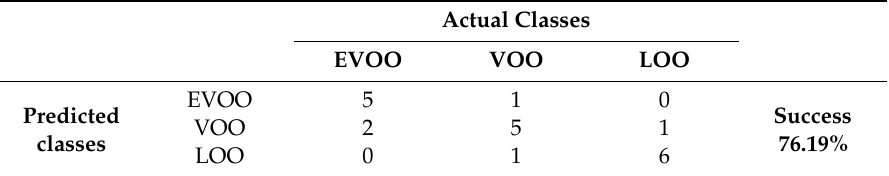
Table 4. Validation matrix by k-NN using chromatographic peak areas obtained with HS-GC-MS.